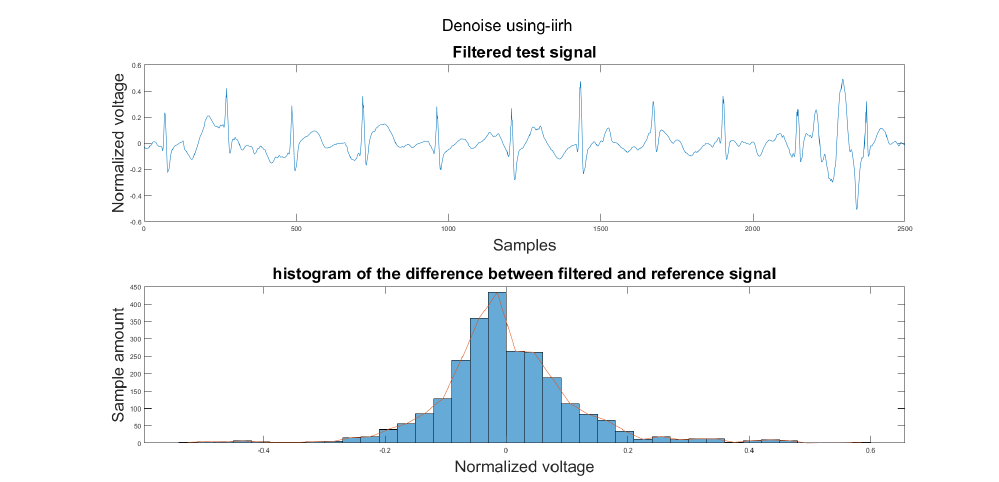
Figure A30. (1) Test signal, (2) histogram of the difference.